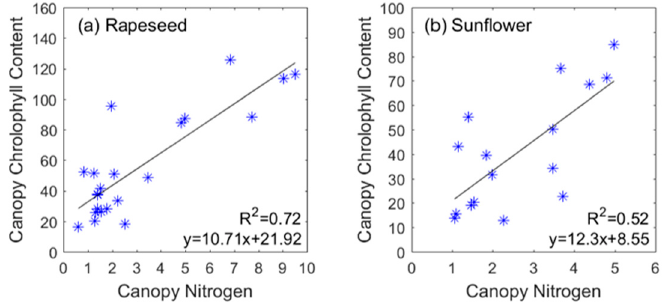
Figure 6. Comparison of estimated canopy chlorophyll content (LAI × C ab , ug/cm 2 ) with ground measured canopy nitrogen content (g/m 2 ) for rapeseed and sunflower. LAI and C ab are estimated from uniform dense LUT. * represents the scatter points.